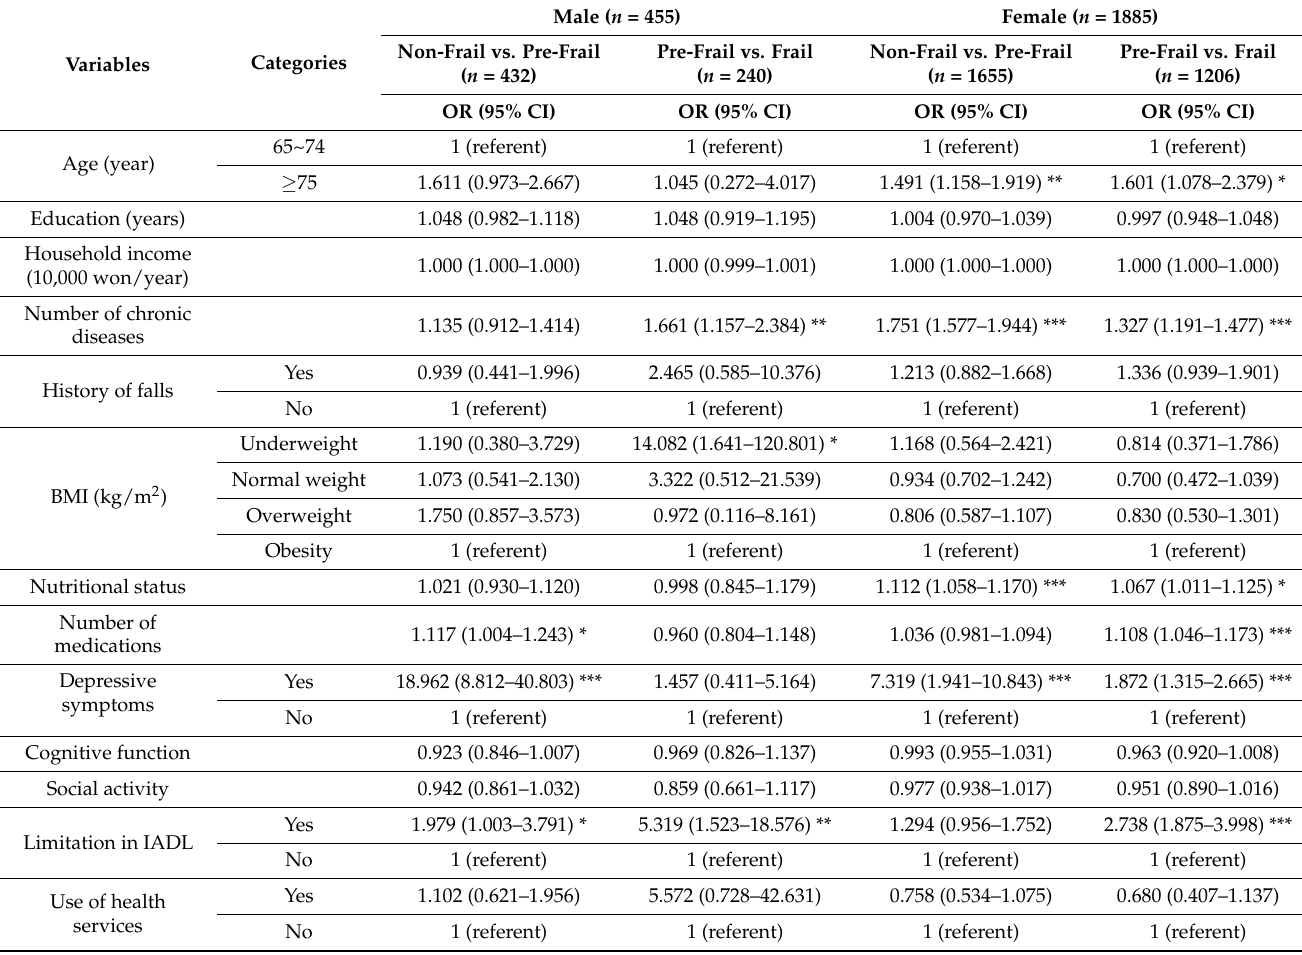
Table 3. Multinomial Logistic Regression of Frailty Status by